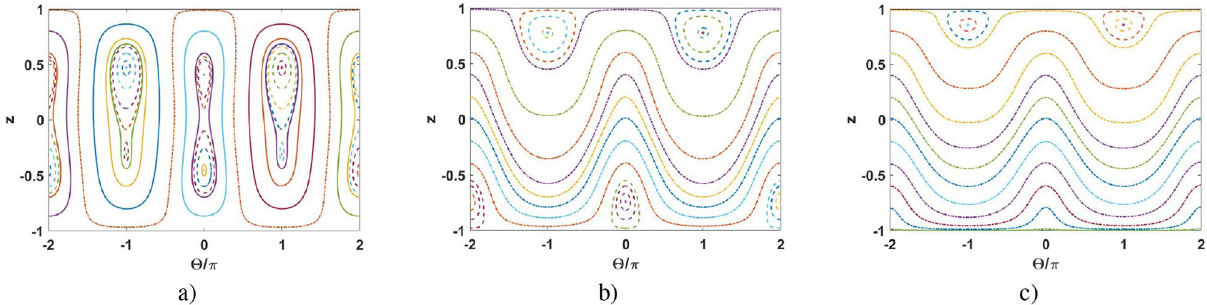
0.75 and for ( a ) �/� (cid:31) at (cid:31) = −